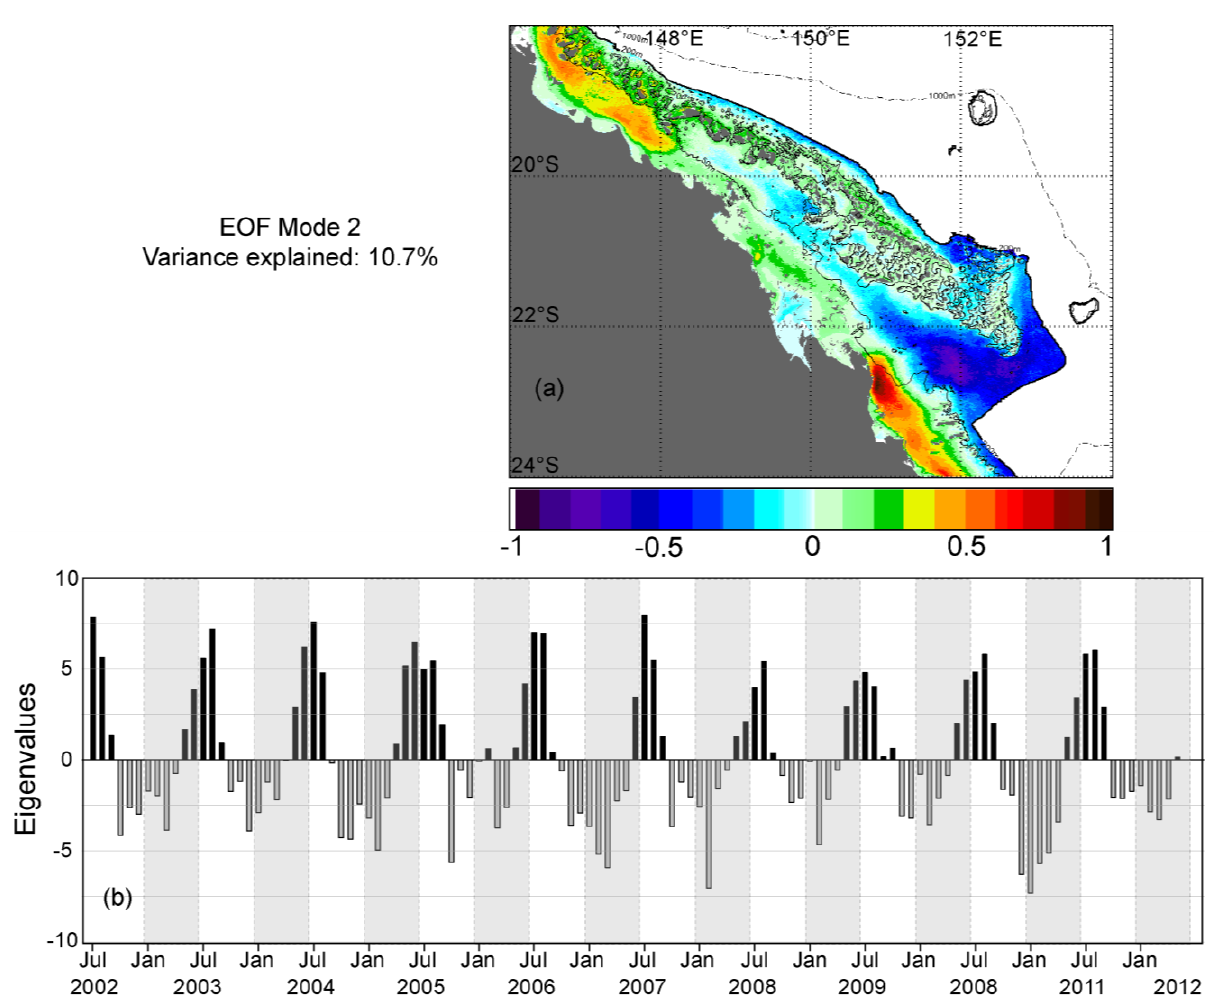
Figure 8. Mode 2 of the Empirical Orthogonal Function Analysis explaining 10.7% of the total variance of water clarity on the central-southern Great Barrier Reef (GBR) from July 2002 to June 2012. The spatial pattern (panel ( a ), normalized from −1.0 to +1.0) shows strong positive values intruding on the central GBR, and opposing positive/negative values in the south, relating most turbid waters coincident with strong East Australia Current dynamics. Panel ( b ) provides the temporal variation associated with the spatial pattern over the 10-year